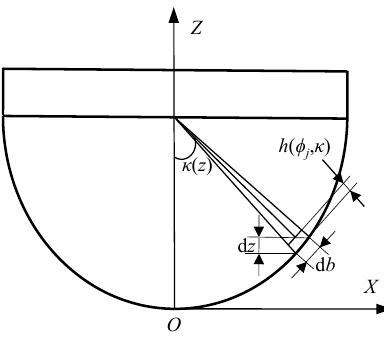
Figure 2. Differential helical cutting edge.